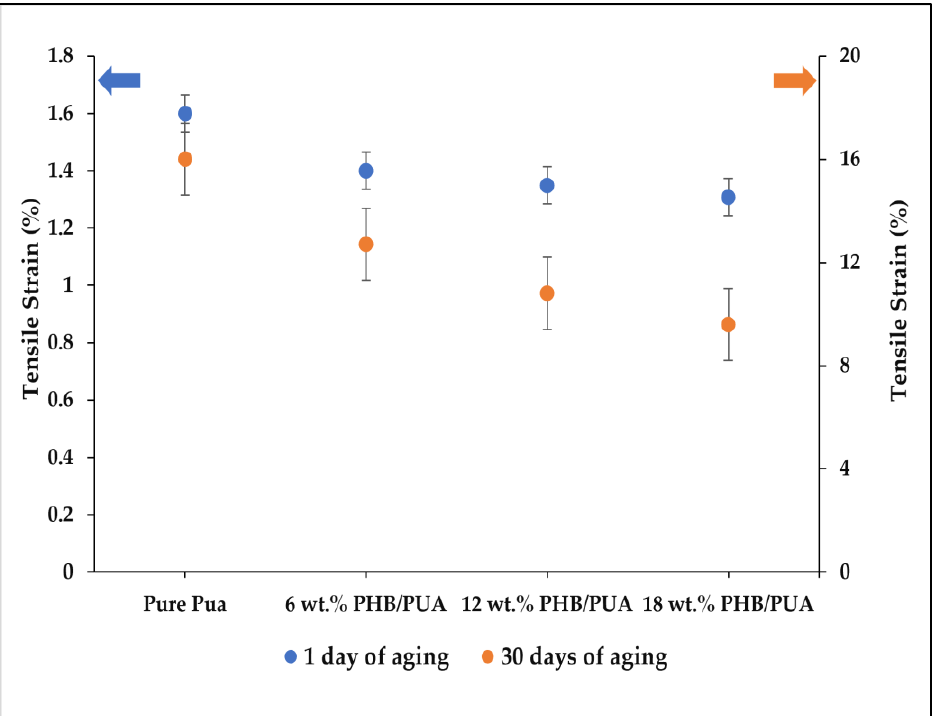
Figure 10. Tensile strain of various 3D-printed PHB/PUA compositions at different aging durations.